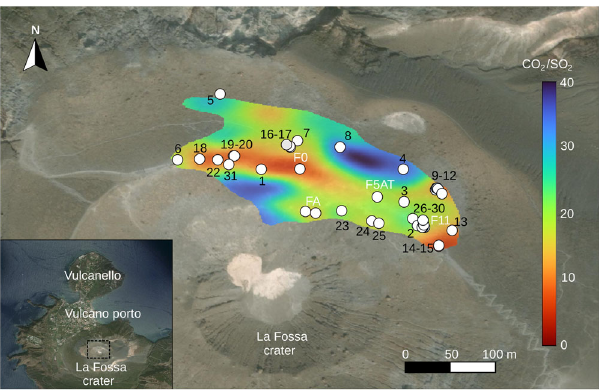
Fig. 3 Mapping the chemical diversity of the La Fossa fumarolic fi eld. The map shows the spatial heterogeneity of the fumarolic CO 2 /SO 2 ratio in the fumarolic fi eld, and is obtained by post-processing the results of the 16 – 18 November 2021 Multi-GAS walking traverses using the methodology of ref. 100 . This processing routine allows resolving the spatial heterogeneity of the fumarolic fi eld with high temporal/spatial resolution, and is thus complementary to the standard protocol used to derive the ratios listed in Supplementary Table 2 (in which all data acquired nearby any single fumarole are jointly analysed). Numbers in the map identify the position of the fumaroles for which compositional results are shown in Supplementary Table 2. The base map used in the fi gure is from sources: Esri, DigitalGlobe, GeoEye, i-cubed, USDA FSA, USGS, AEX, Getmapping, Aerogrid, IGN, IGP, swisstopo, and the GIS User